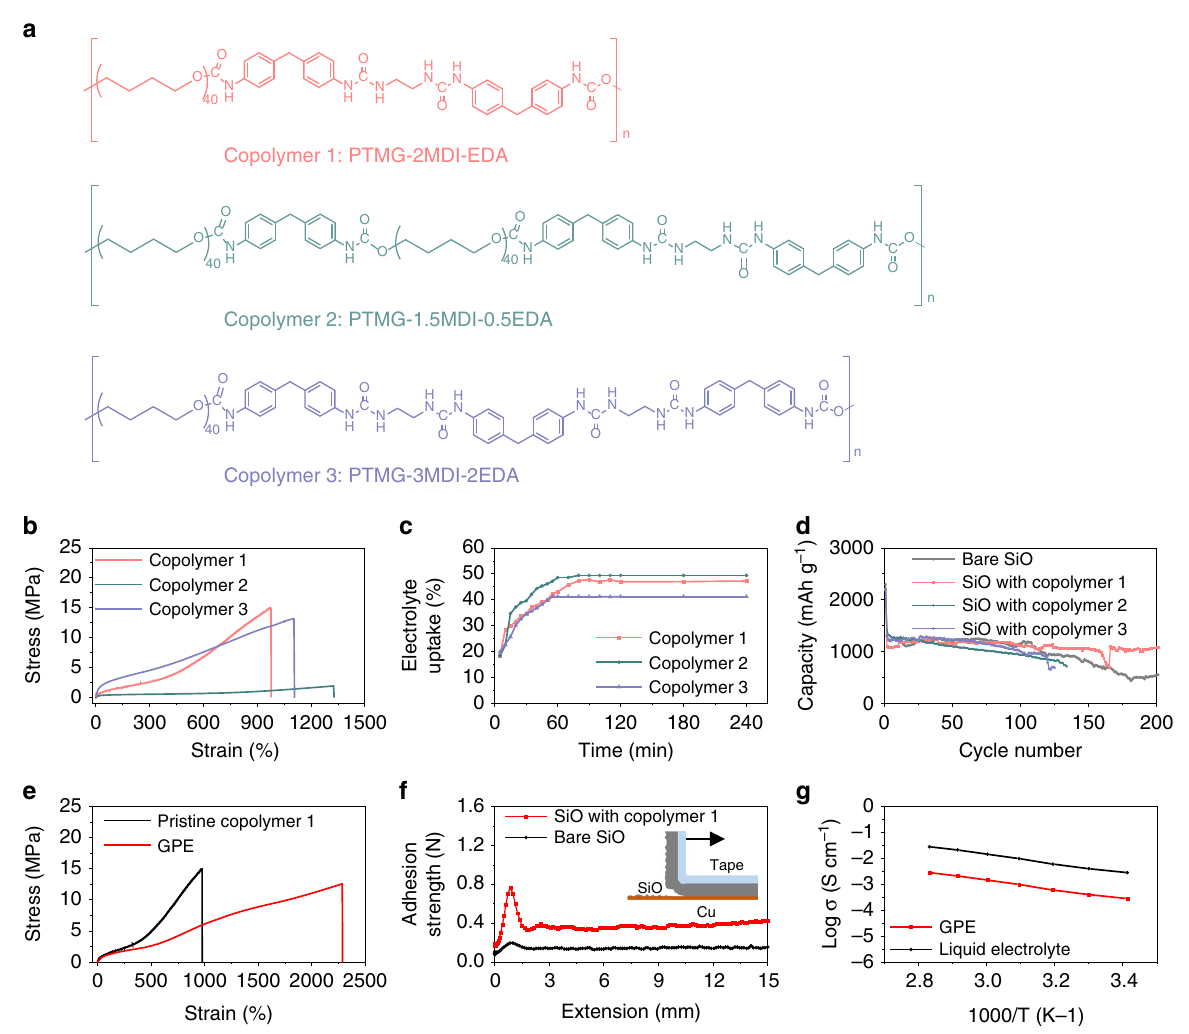
Fig. 2 Structural optimization and characterization of the elastic GPE. a Structure of the copolymers, containing a soft domain (PTMG) and a hard domain (MDI-EDA) with different ratios. b Stress-strain curves of the copolymers. c Swelling test of the polymer membranes in a 1 M LiPF 6 in EC/DEC electrolyte. d Cycling stability of the SiO electrodes with the copolymers. The mass loading of SiO electrodes is 3.7 mg cm − 2 , and the copolymer amount is 0.4 mg cm − 2 . e Stress-strain curves of the copolymer 1 before and after swelling. f Peel adhesion of SiO electrodes. The electrode was peeled-off from the Cu current collector using a 90-degree dragging force. g Ionic conductivity measurement of the elastic GPE and liquid electrolyte as a function of